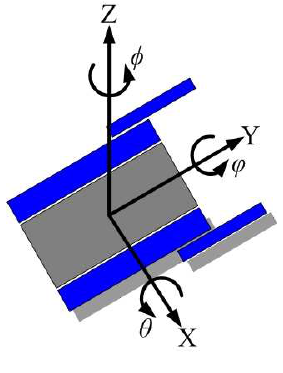
Fig. 1. The coordinate of the